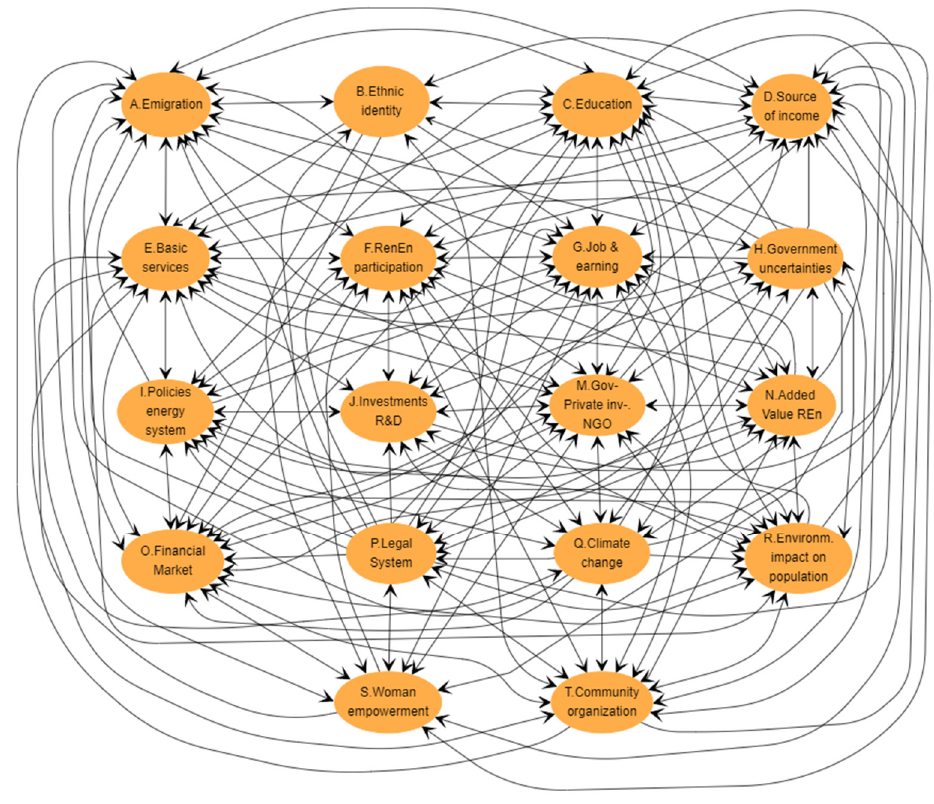
Figure 7. Interdependencies among descriptors. The arrows indicate the direction of the influ- ences.